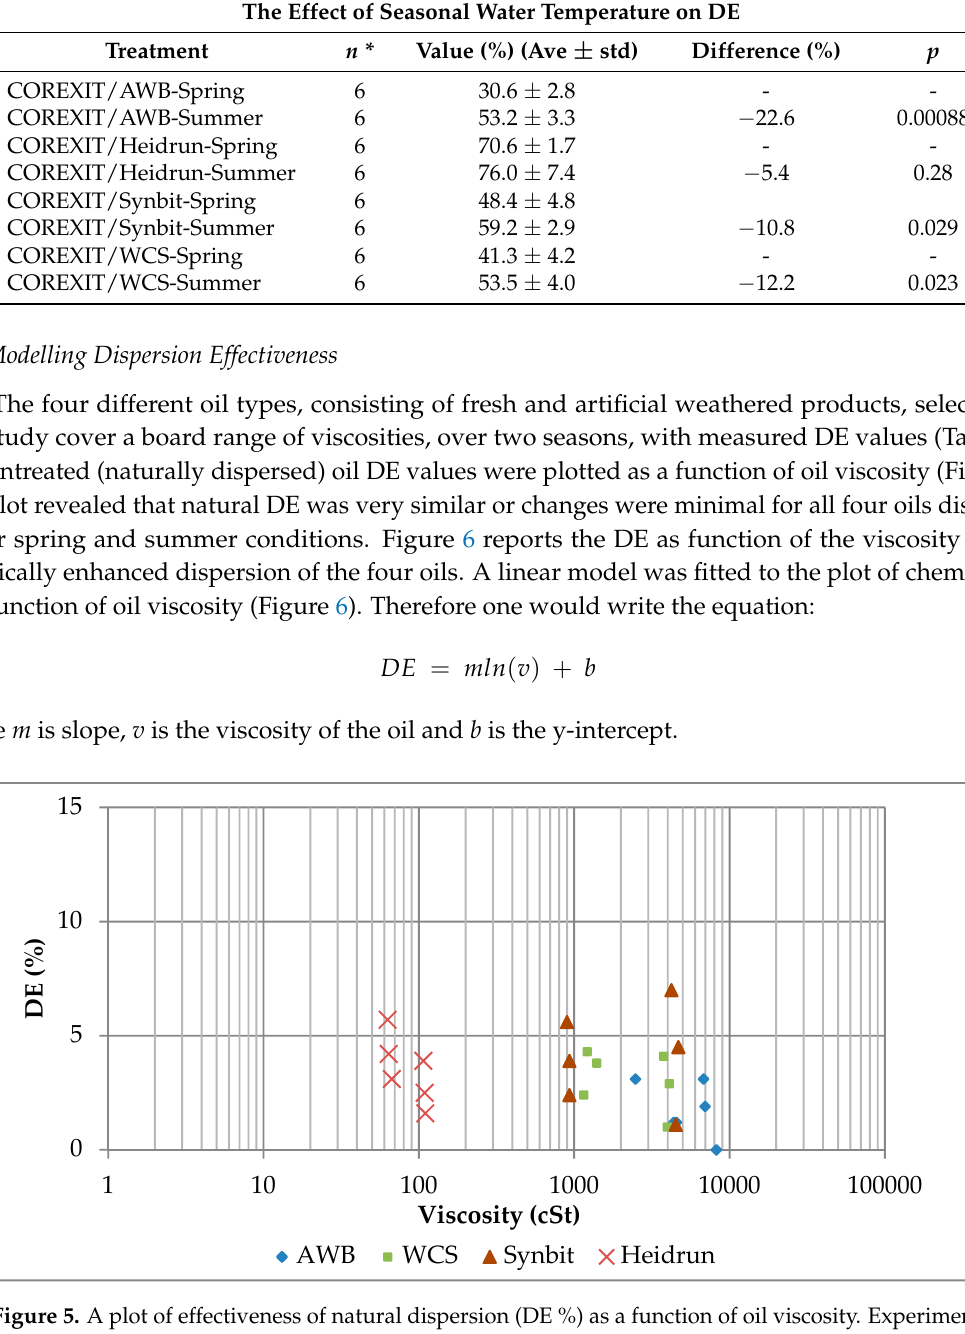
Table 3. Analysis of Variance of the randomization tests show the DE of oils affected by seasonal water temperatures under breaking waves. The value of “ p ” provides information on the probability of the observation (i.e., difference) to be due to randomness. The smaller the value of “ p ” the less likely the difference is due to randomness. Average ± standard deviation (Ave ± std).